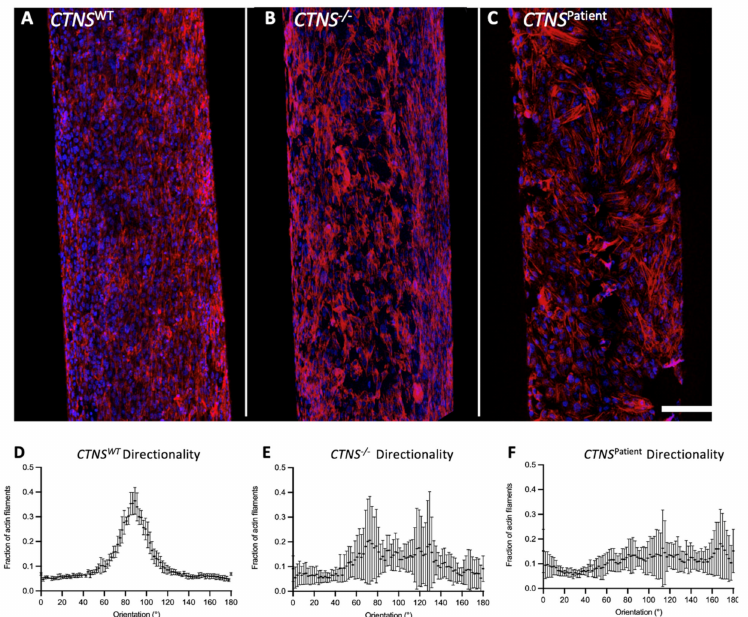
Figure 2. Cellular organization of kidney tubules. Kidney tubules were stained using phalloidin to show the organization of actin filaments in ciPTEC CTNS WT ( A ), CTNS − / − ( B ), and CTNS Patient ( C ). Both cystinotic models ( B , C ) present a disrupted cell monolayer with visible holes along the membrane when compared to the control cells ( A ), which is also seen in the image directionality quantification ( D – F ). In blue: DAPI (nuclei staining), in red: Phalloidin (binds to actin filaments). Directionality analysis was performed in three biological replicates. Scale bar: 100 µ m.